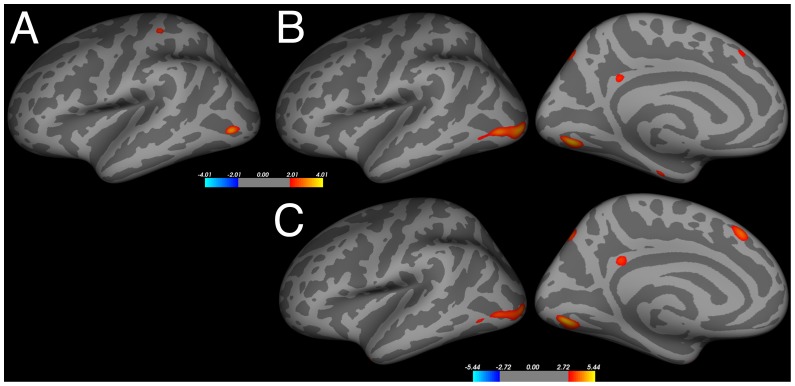
The association between performance on the visuo-spatial divergent thinking task (CAT) and cortical thickness observed in the whole-brain analyses.(A) Positive association with CAT fluency. (B) Positive association with CAT originality. Note, TIV, age and sex were used as nuisance variables, FDR-corrected, p<0.05 in both figures. (C) Positive association with CAT originality corrected for IQ. Note, TIV, age and sex were used as additional nuisance variables, FDR-corrected, p<0.05 in all figures. Hot colors indicate cortical thickening, cool colors thinning.